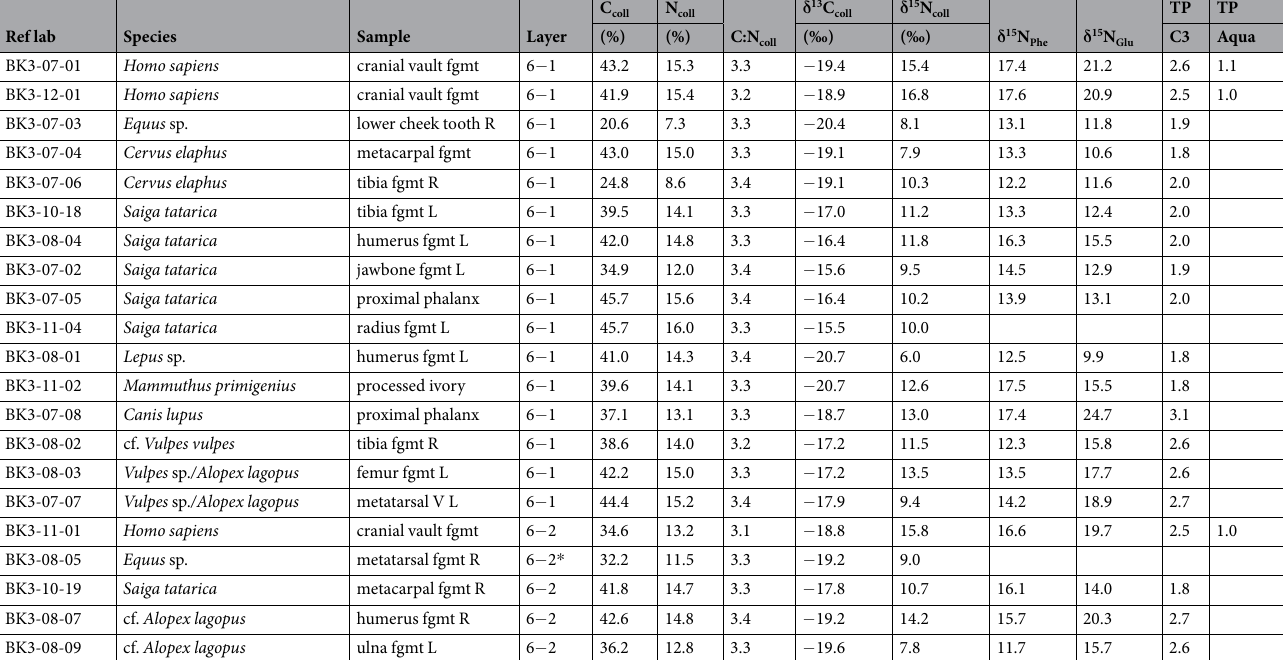
Table 2. Results of stable isotope analyses of collagen ( δ 13 C coll , δ 15 N coll , δ 15 N Phe , δ 15 N Glu ) from the animal and human samples of Buran-Kaya III. The carbon and nitrogen composition of the collagen is given through elemental composition (C coll , N coll ) and atomic ratio (C:N coll ). fgmt stands for fragment, L for left and R for right, * indicates that the former stratigraphy position is now questioned based on the direct radiocarbon date (possible re-attribution to 6–3 26